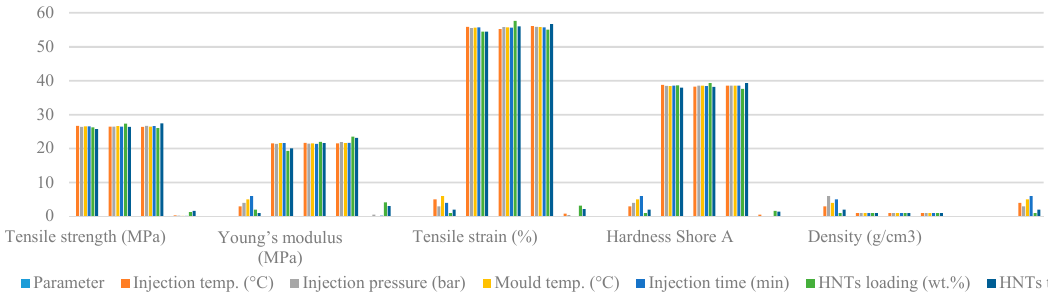
Figure 4. Response for S/N ratios “larger is better”. Table 5. ANOVA average on mechanical and physical properties.